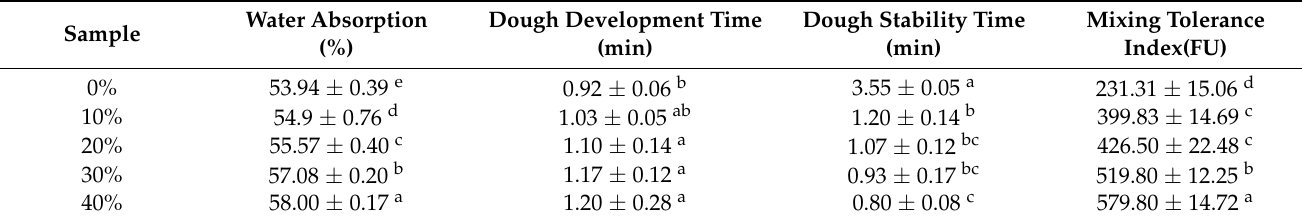
Table 3. Farinograph properties of GBP/wheat flour